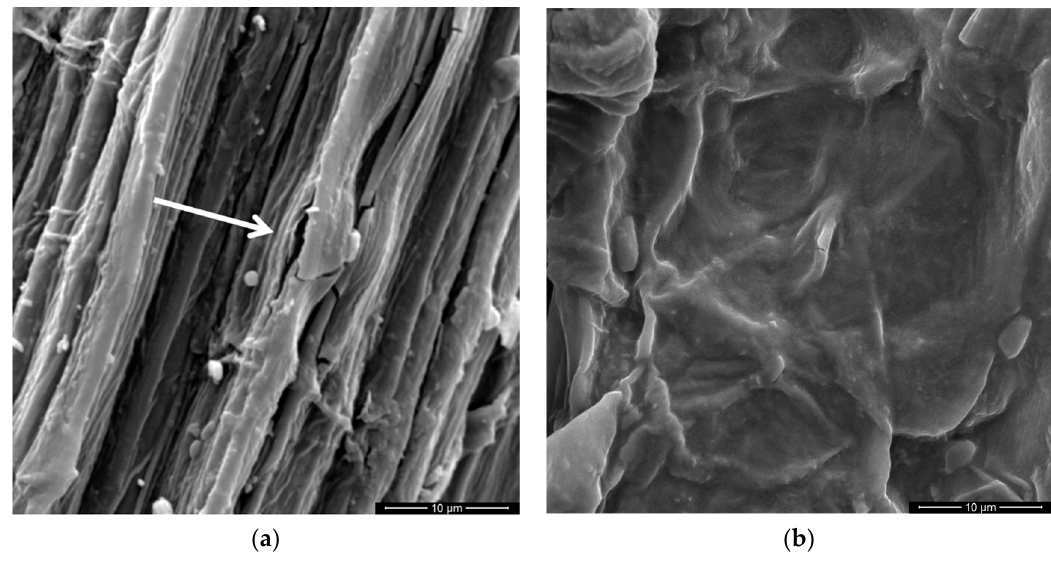
Figure 9. SEM surface images of both fibers: ( a ) CF; ( b ) Figure 9 . SEM surface images of both fibers: ( a ) CF; ( b ) GOCF.